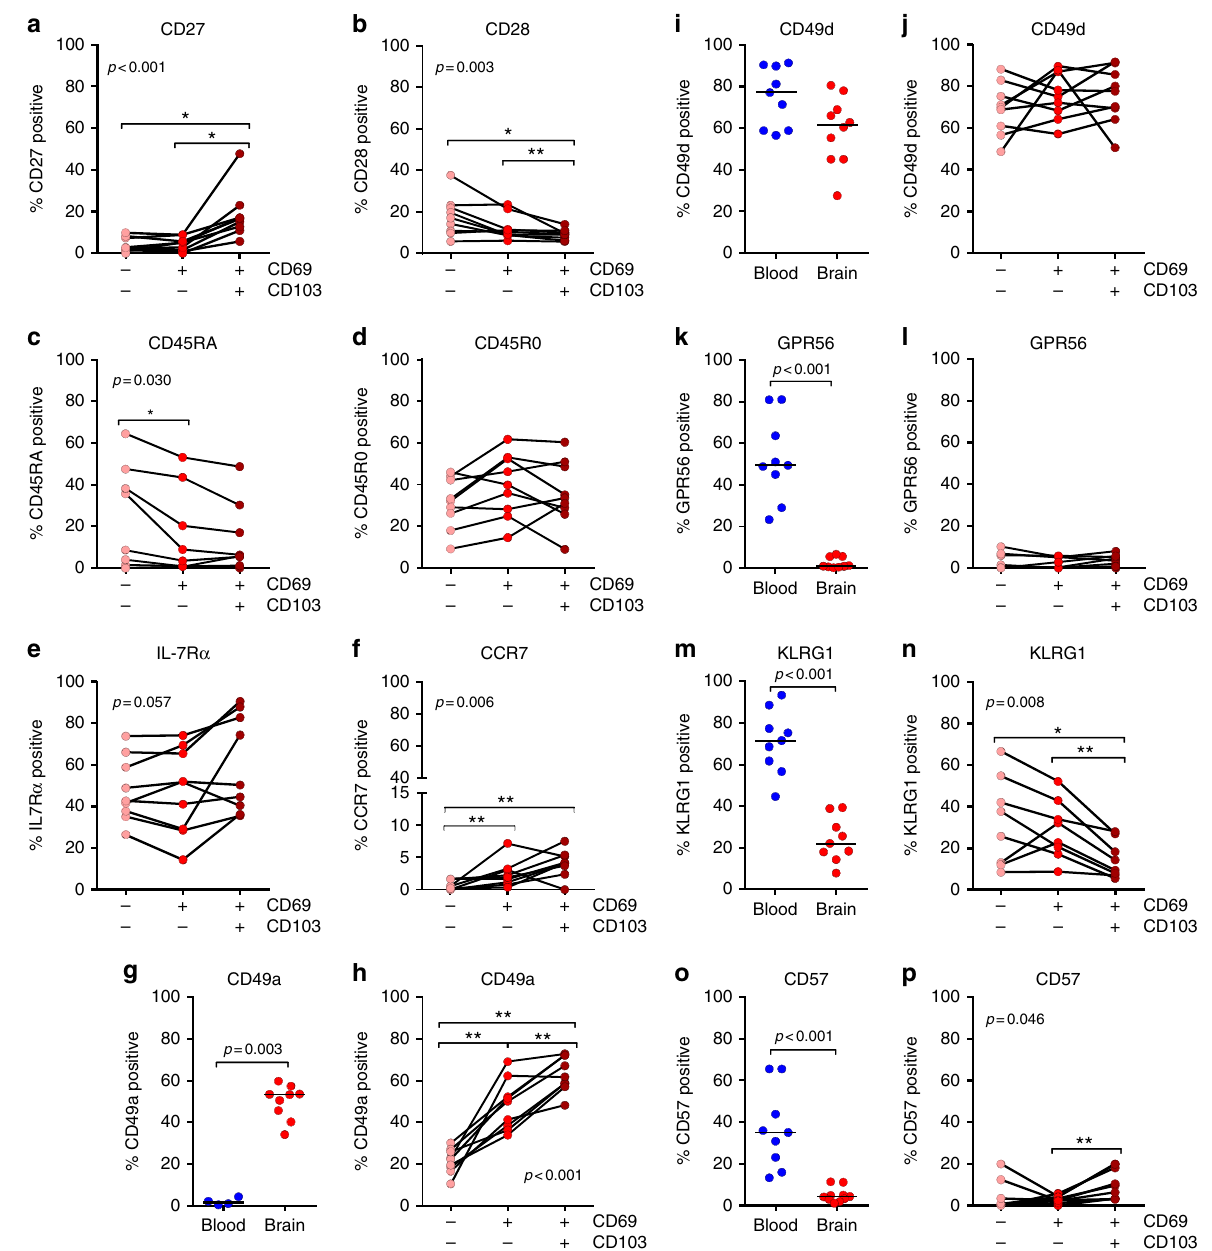
Fig. 3 Human brain CD8 + T cells distinctly express surface markers, based on CD69 and CD103 co-expression. a – p Quanti fi cation of CD8 + T cells expressing CD27, CD28, CD45RA, CD45R0, IL-7R α , CCR7, CD49a, CD49d, GPR56, KLRG1, and CD57, respectively, in n = 9 donors. Bars show median values. p -values show Mann – Whitney U test for unpaired data ( g , i , k , m , o ) and Friedman test for paired data with Wilcoxon signed ranks as post hoc test ( a – f , h , j , l , n , p ) (* p < 0.05, ** p < 0.01); no brackets indicate no signi fi cant